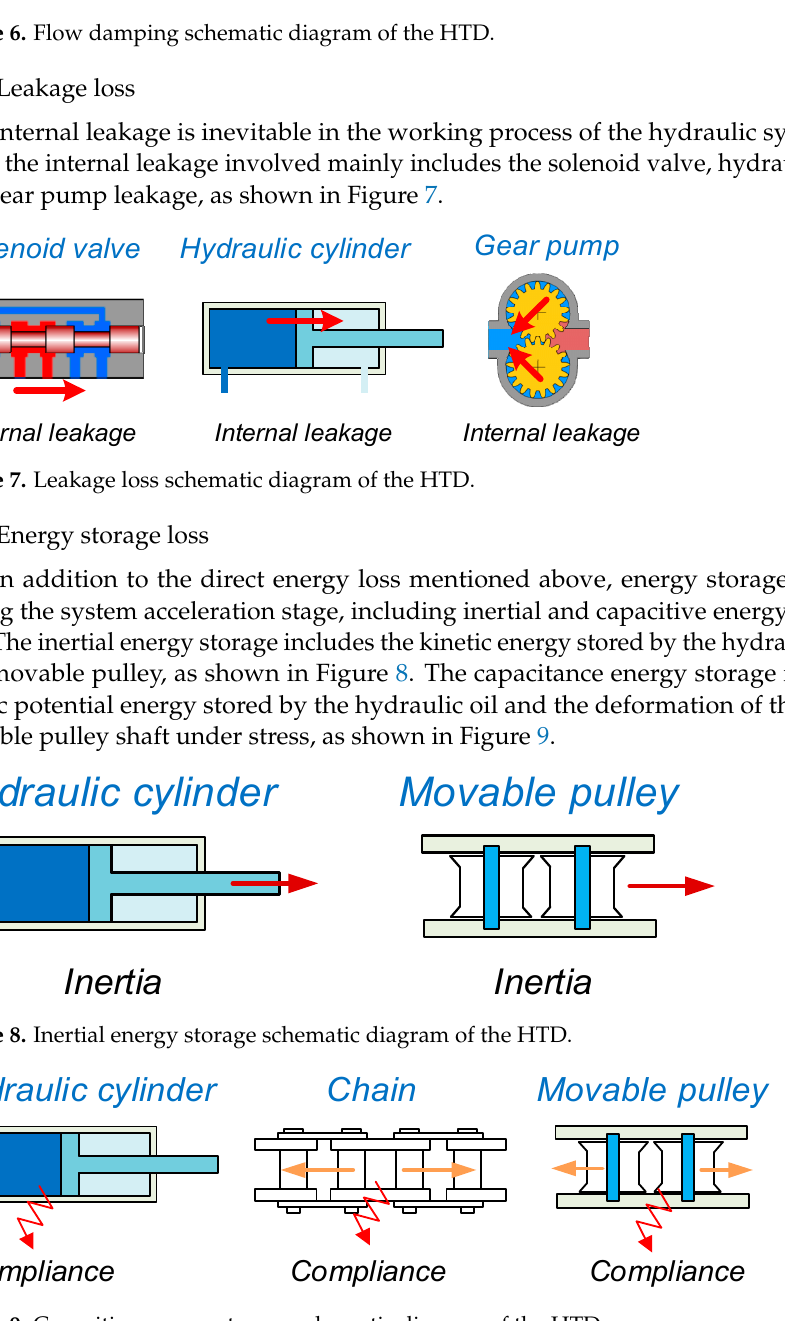
Figure 6. Flow damping schematic diagram of the HTD.